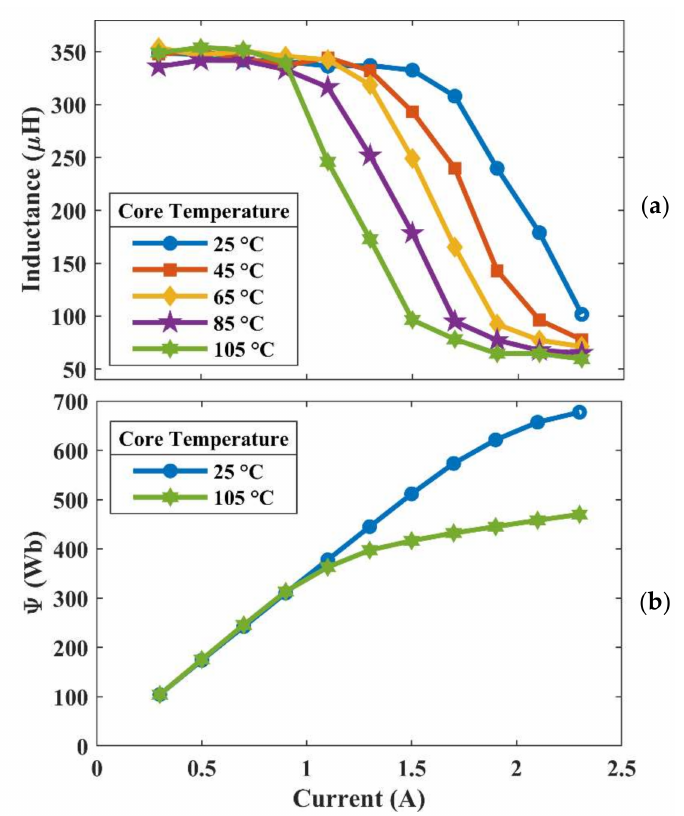
Figure 5. Inductor 2 characteristics as a function of temperature: ( a ) inductance vs. current; ( b ) flux curve vs.